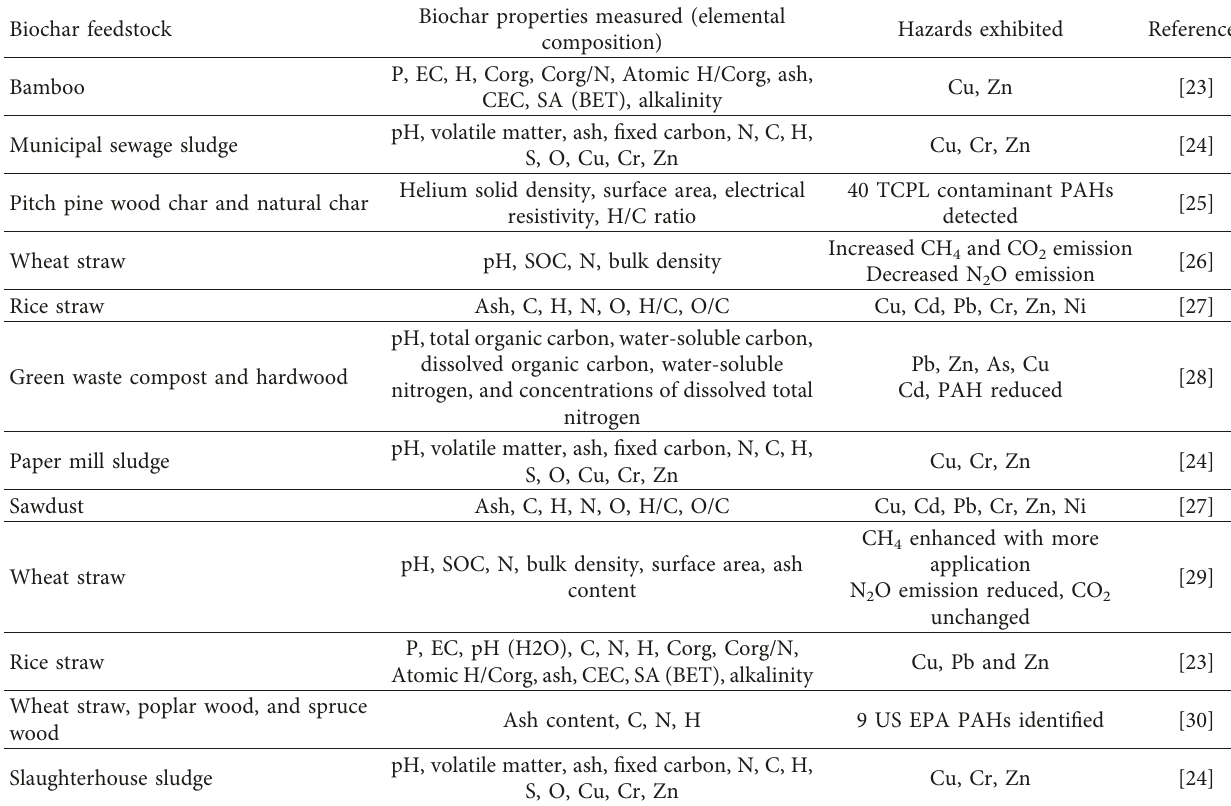
Table 1: Biochar properties and hazards exhibited. Biochar properties measured